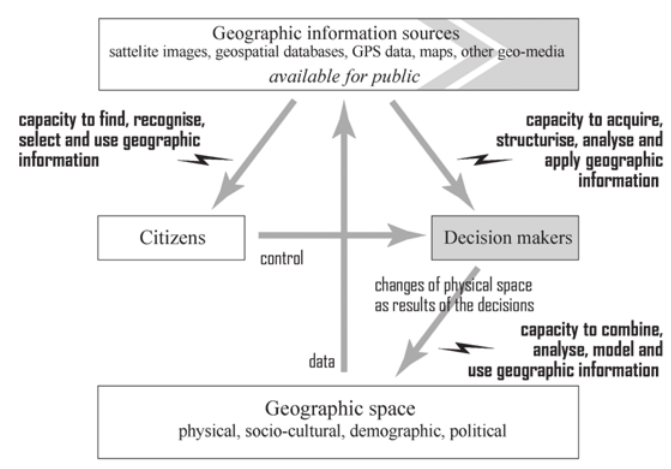
Fig. 1. Geographic information in